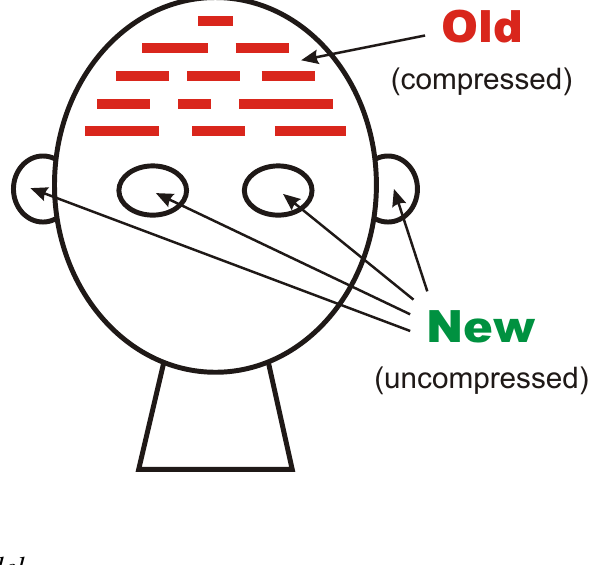
Figure 1. Schematic representation of the SP system from an “input”